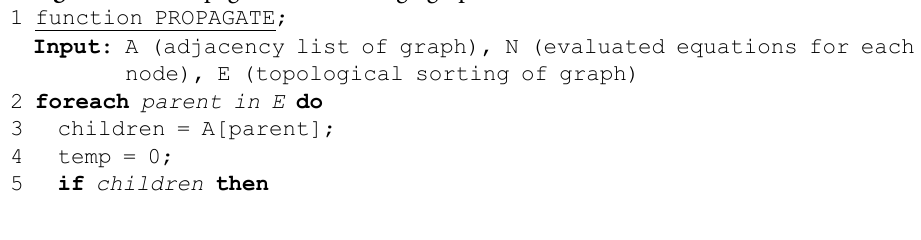
Algorithm 1 : Propagate values through